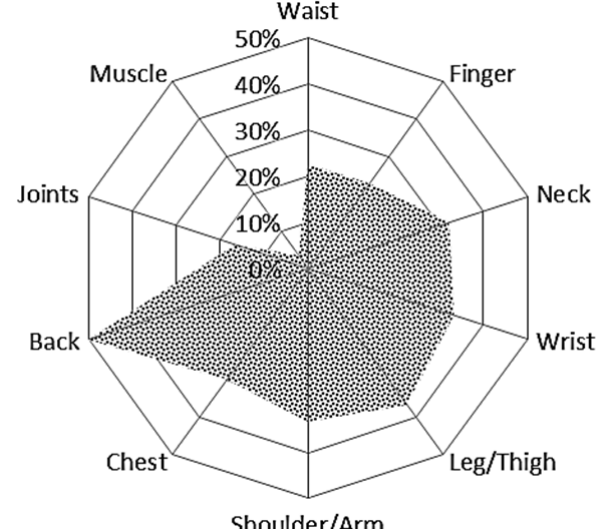
Figure 2. Complaints of body discomfort by workers in the small-scale feed